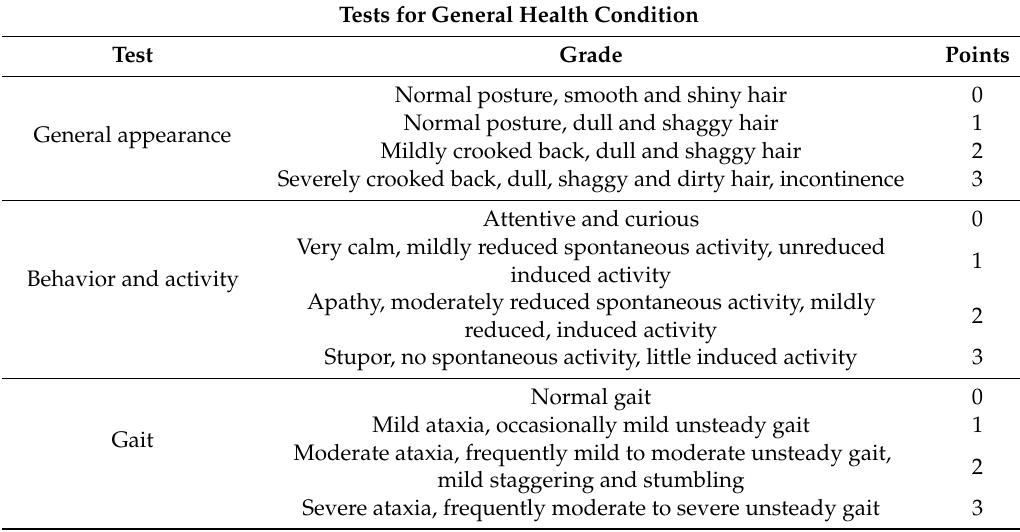
Table 2. Scoring of clinic and behavioral changes of Glb1 − / −